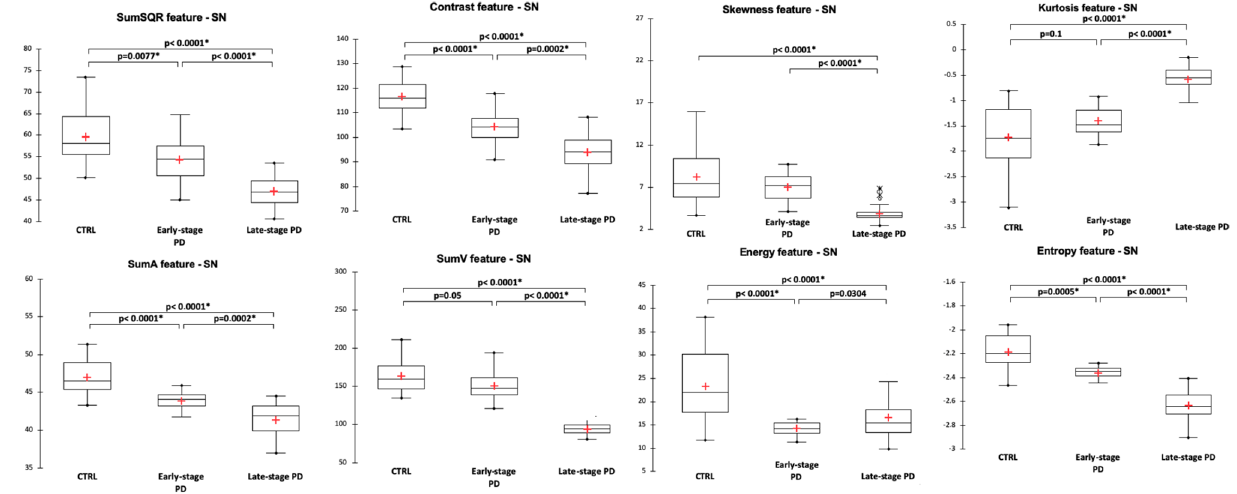
Figure 2. Comparison of texture features in the substantia nigra between healthy controls (CTRL), early-stage PD and late-stage PD